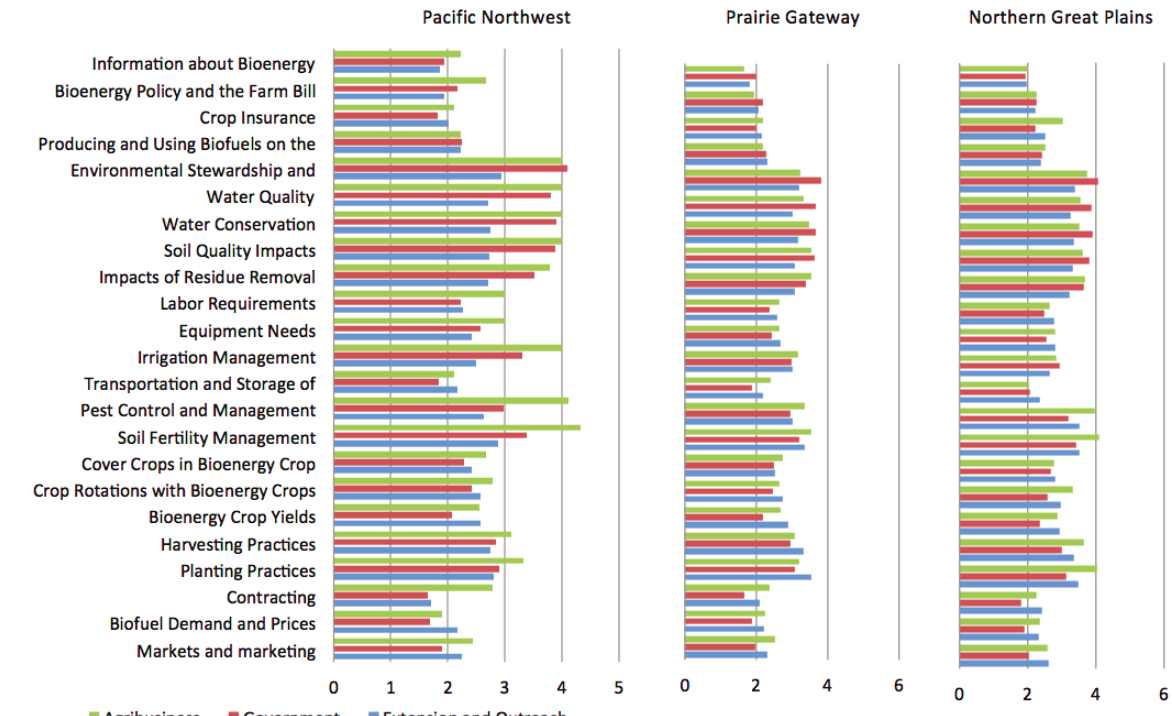
Figure 5: Mean knowledge level of concepts by extension educators and other outreach personnel might about production of feedstocks and bioenergy crops on a Likert scale: 1= no knowledge, 2= little knowledge, 3= some knowledge, 4= knowledgeable, 5= very knowledgeable. (Sample size for each region is: Pacific Northwest N = 117; Prairie Gateway N = 396; and Northern Great Plains N =